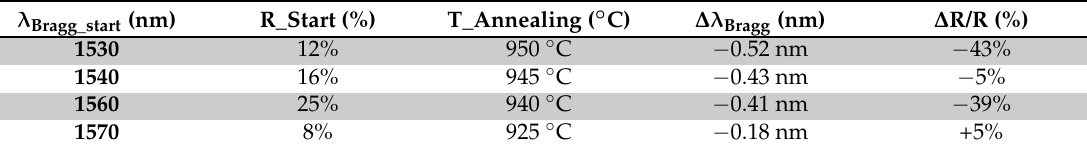
Figure 11. Bragg Wavelength Shift ( left ) of four identical IR-fs-PbP FBGs written and annealed at four different temperatures at CEA List laboratory together with room temperature reflection spectrum ( right ) for one of these FBGs before and after annealing during 2200 h at 945 ◦ C. Table 2. Spectral characteristics measured before and after the long term thermal annealing at four distinct temperatures of four IR-fs-PbP FBGs written in SMT-A1310H optical fibre. ∆ R/R and ∆ λ Bragg stand respectively for the normalized change of the Bragg peak maximum amplitude and of the Bragg wavelength shift before and after annealing, at room